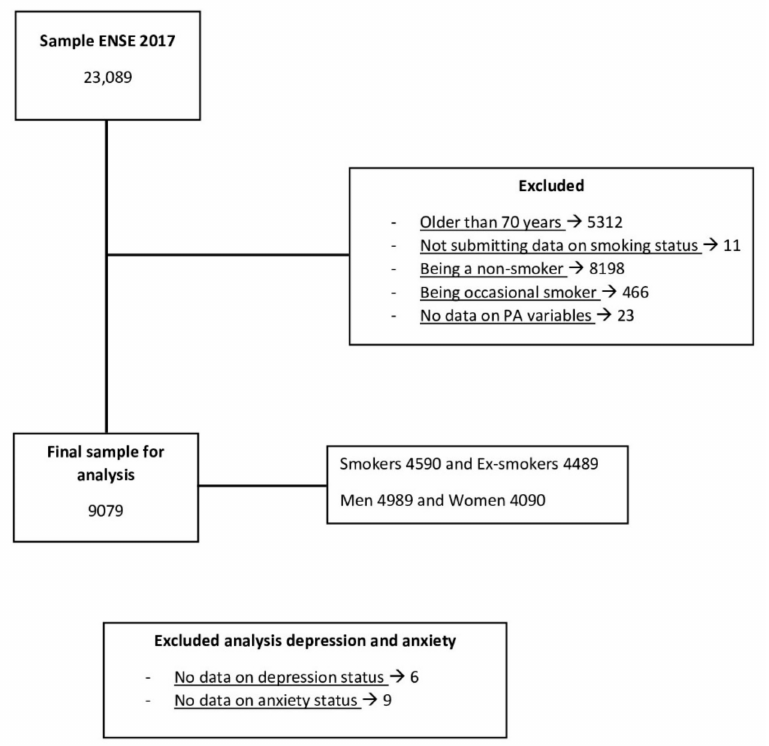
Figure 2. Sample exclusion criteria (sub-study